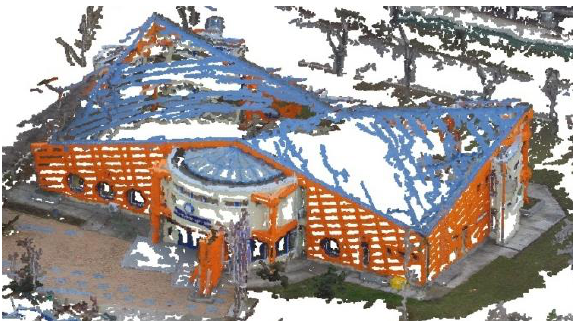
Figure 5. The „Dean’s office” building model created in the Visual SfM software based on UAS images, represented as